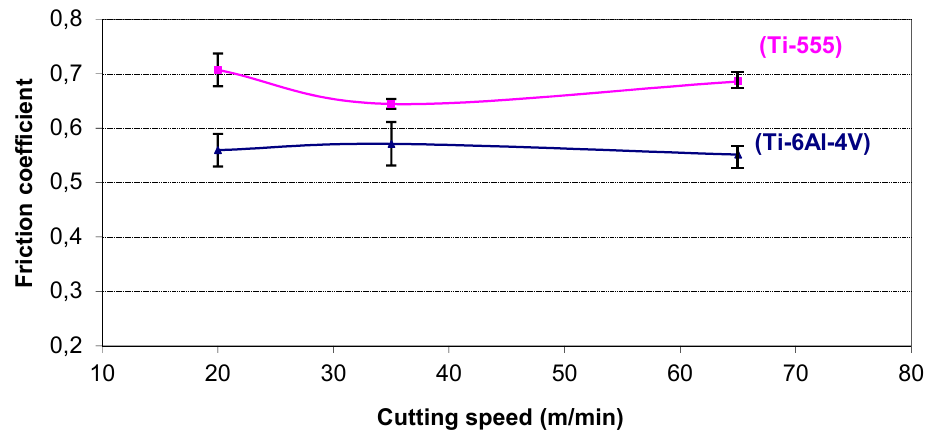
Figure 8. Evolution of the friction coefficient in the tool/chip interface. (Tool geometry “B”, rake angle 0°).